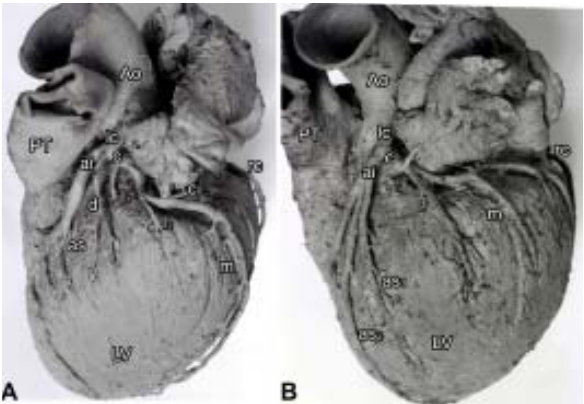
Fig. 2 - Vista lateral esquerda do coração em dois casos com dominância da artéria coronária direita. A aurícula foi rebatida com alfinete. A. O ramo ântero-superior (as) é curto, o ramo diagonal (d) é médio e os dois ramos laterais (l1 e l2) são curtos. B. Dois ramos ântero-superiores, um médio (as1) e um longo (as2), são ladeados por um ramo lateral (l). Ao= aorta; TP= tronco pulmonar; VE= ventrículo esquerdo. ce= artéria coronária esquerda; ia= ramo interventricular anterior; c= ramo circunflexo; m= ramo marginal esquerdo; cd= artéria coronária